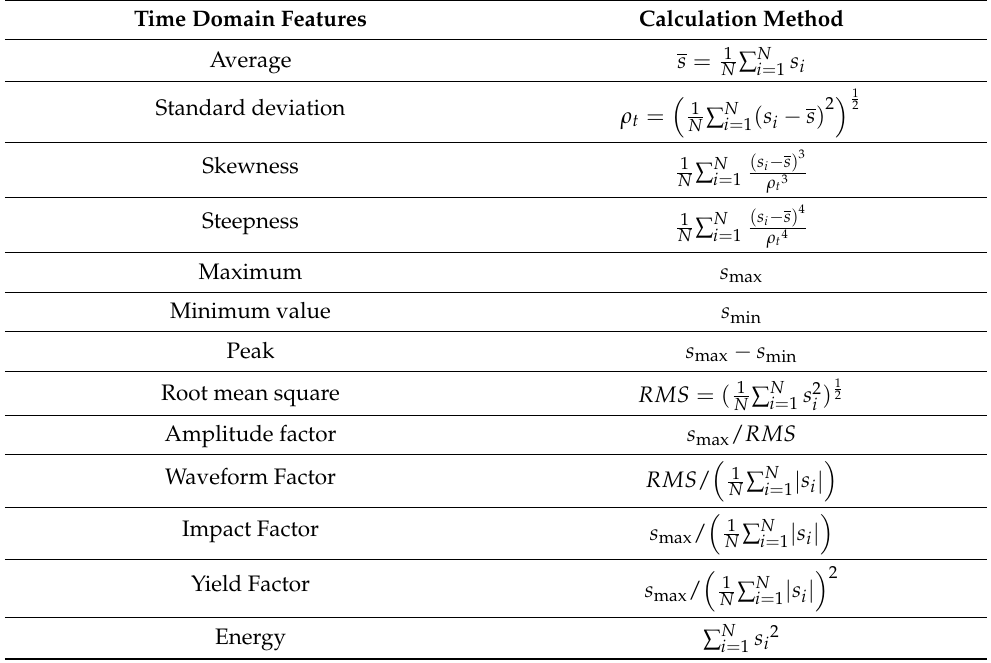
Table 1. Feature extraction formula.